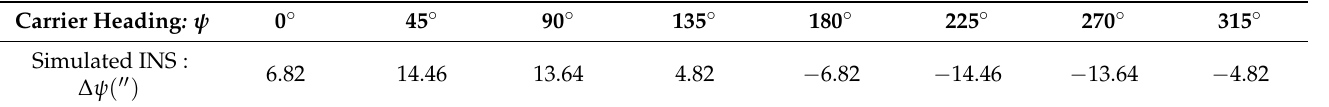
Table 2. Theoretical value of 8-orientation simulation test heading